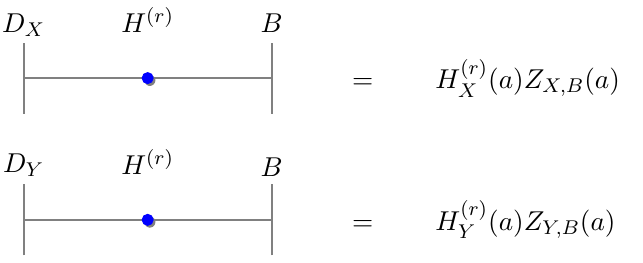
Figure 10 . The insertion of a supersymmetric ’t Hooft loop between a boundary conditions D X ( a ) and B acts as a di(cid:11)erence operator on the wave function Z X;B ( a ). In the ‘classical’ limit b 0, the di(cid:11)erence operators H ( r ) ( a ) coincide with the X !